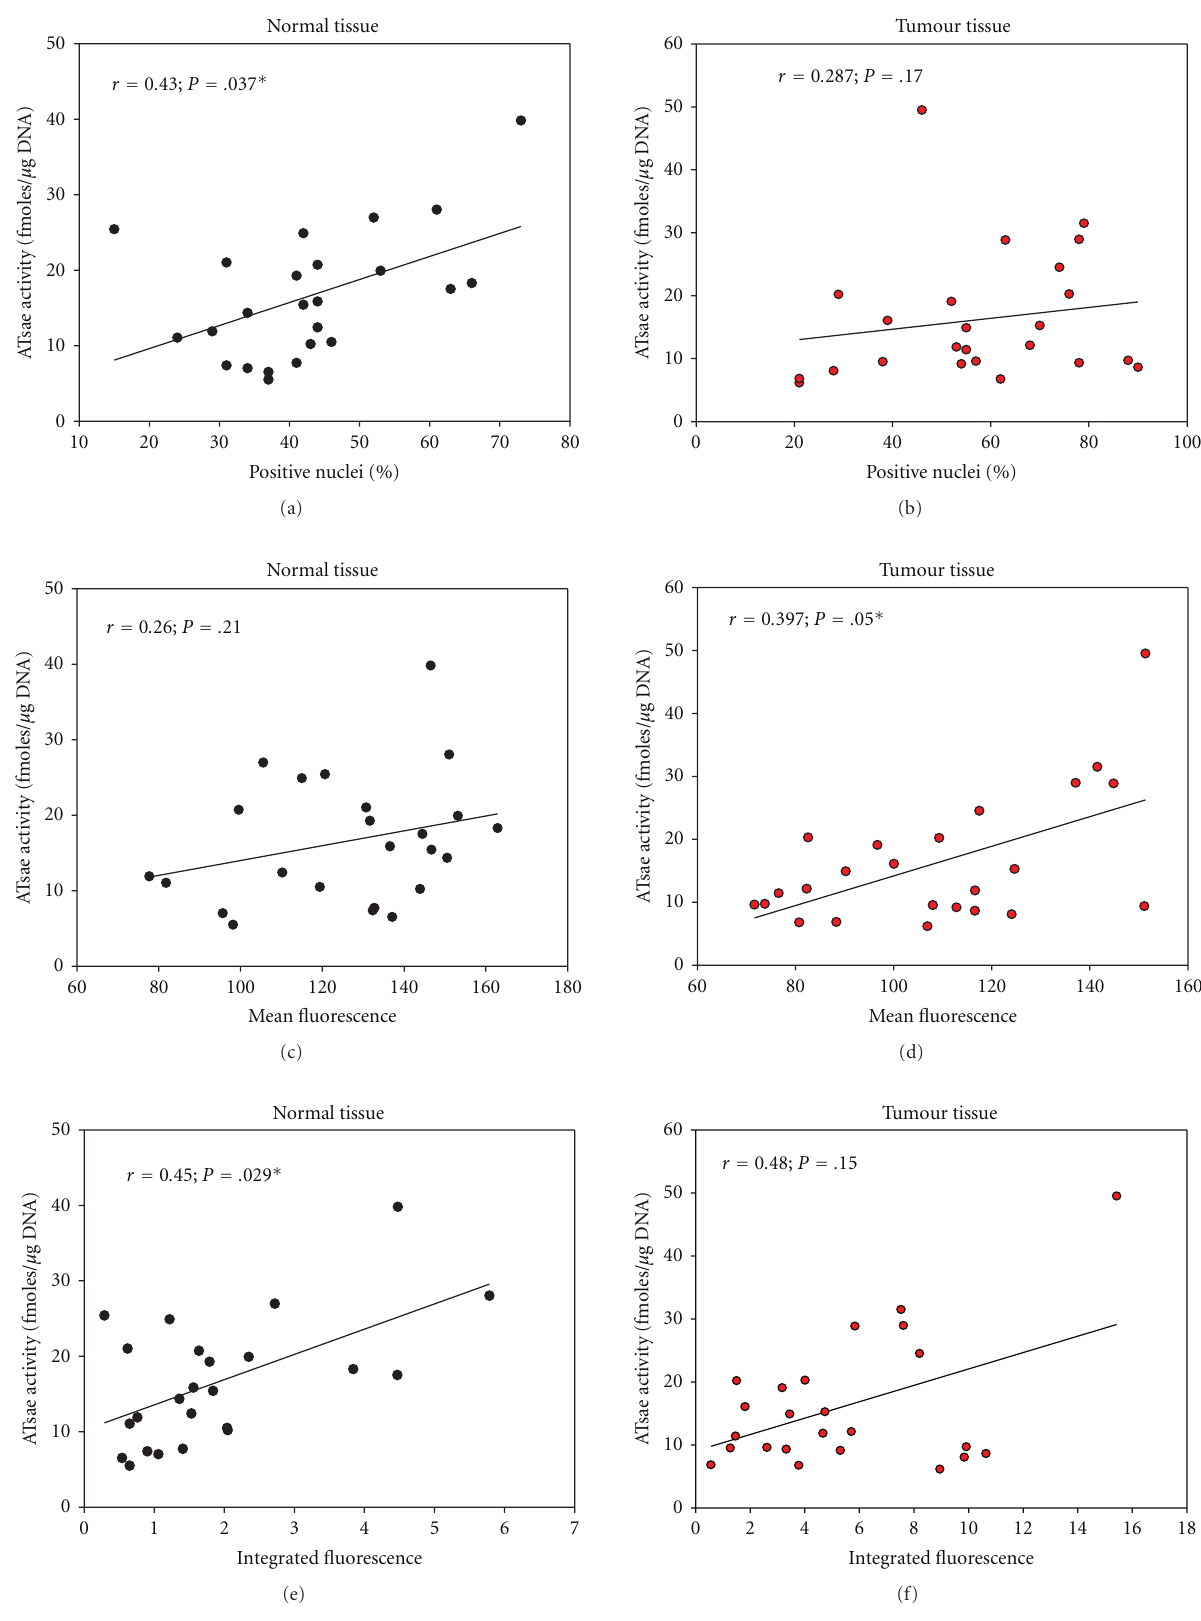
Figure 5: Relationship between MGMT activity (fmole/ µ g of cellular DNA) and immunofluorescence parameters of MGMT content (top: %positive nuclei, middle: mean fluorescence, bottom: integrated fluorescence) in normal and tumour